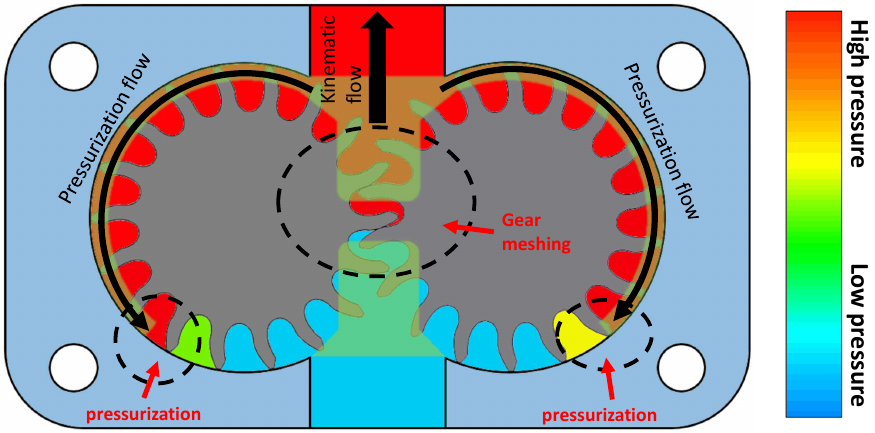
Figure 5. A gear pump with a tooth-space being pressurized by the backflow